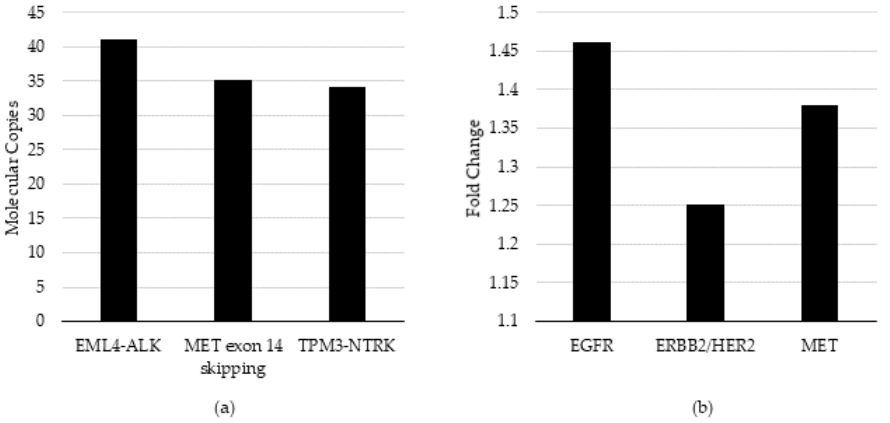
Figure 2. QC threshold evaluation and limit of detection verification. ( a ) Fusion/skipping variant types measured as molecular copies and ( b ) CNA variant types measured as fold-change were evaluated using the pre-set QC thresholds in the Oncomine Pan-Cancer assay bioinformatic pipeline and assessed detection at or near the pre-determined LOD.